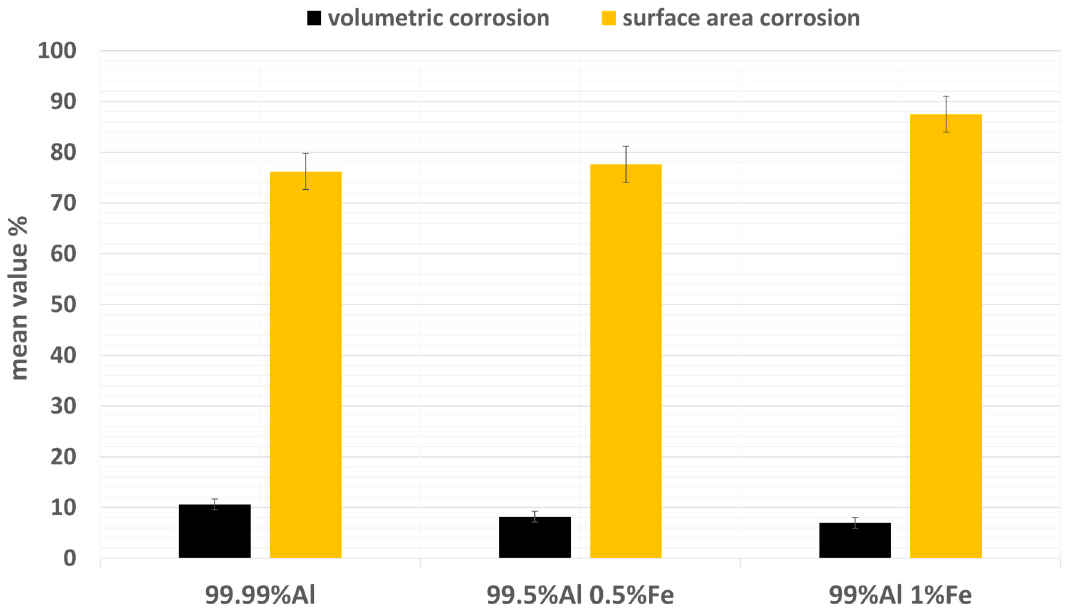
Figure 6 . Volumetric and surface area corrosion for Al electrodes with different Fe contents. Al-NG cells using Al alloy anodes with higher Fe contents, 99% Al 1% Fe and 99.5% Al 0.5% Fe, respectively, have about 48% and 24% longer cycling lifetime, compared with 99% Al 1% Fe (as seen in Table 1). The corresponding Al electrodes 99.99% Al, 99.5% Al 0.5% Fe, and 99% Al 1% Fe exhibit fractional surface area corrosion of 76.2%, 77.6%, and